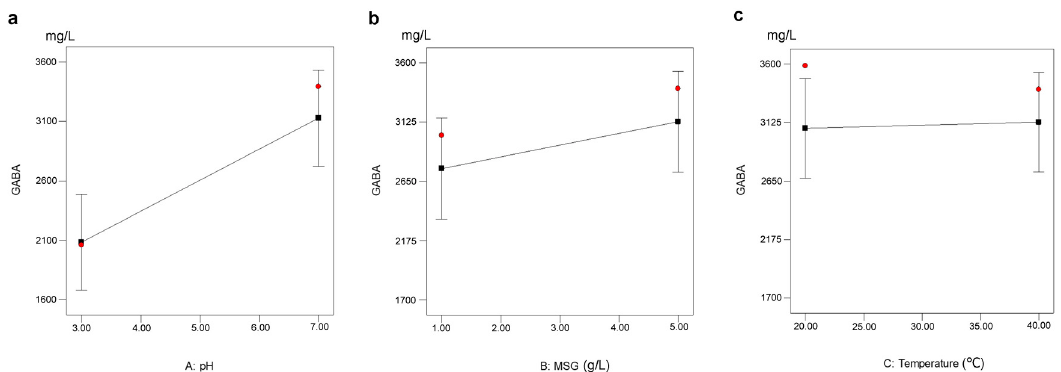
Figure 4. One factor profiles, which demonstrated the effects of ( a ) pH, ( b ) MSG concentration (g L − 1 ), and ( c ) temperature (°C) on GABA production of B. cereus KBC.